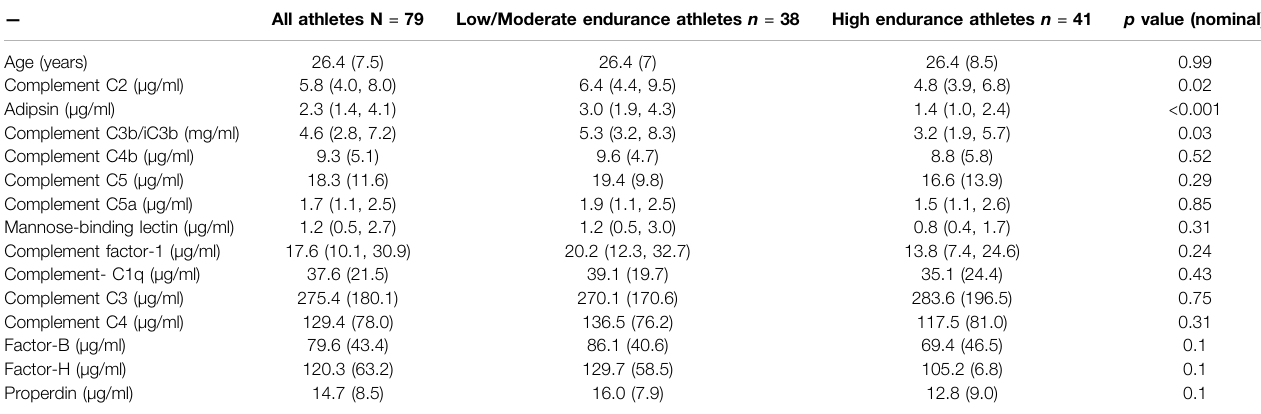
TABLE 2 | Comparing levels of complements between high versus low/moderate elite endurance athletes. — All athletes N = 79 Low/Moderate endurance athletes n = 38 High endurance athletes n =